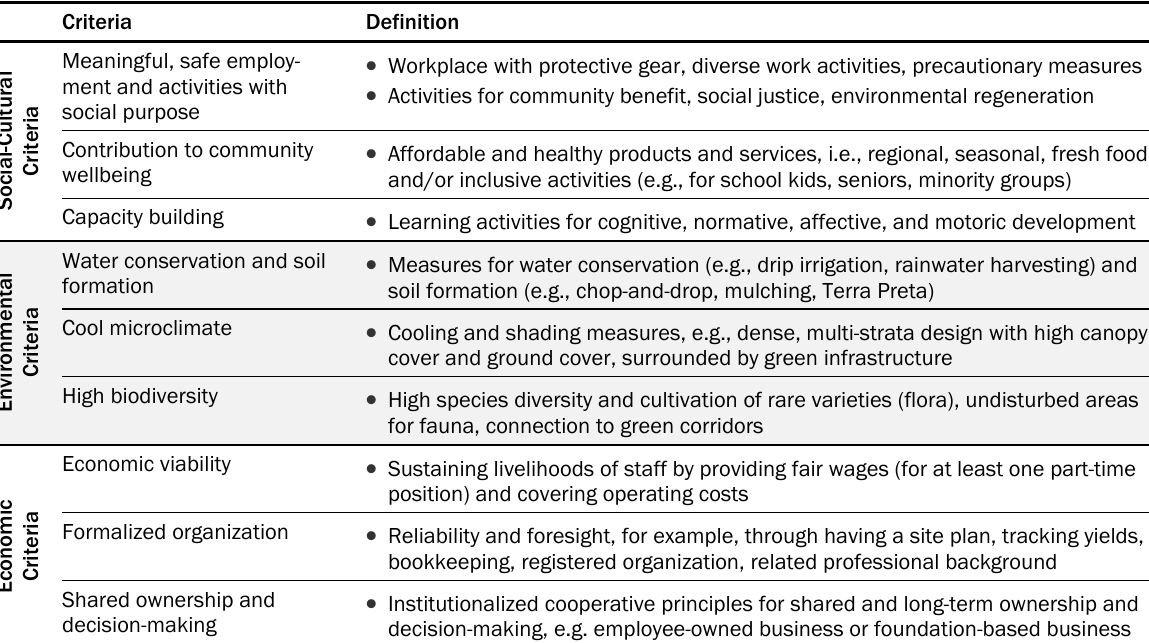
Table 1. Sustainability Criteria for Food Forests Criteria